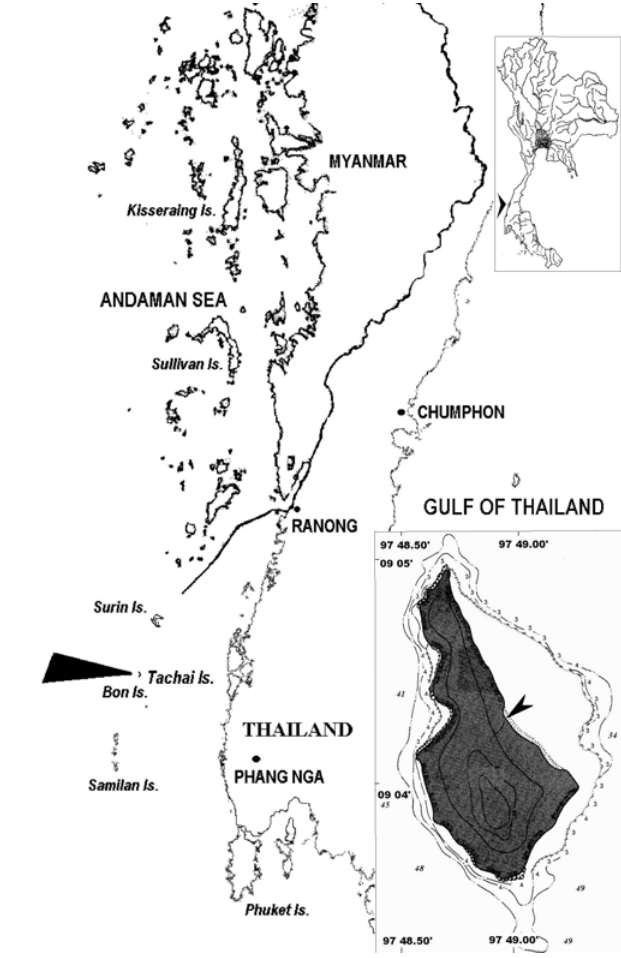
Figure 1. The part of the Mergui Archipelago adjacent to the western coast of the Thai Peninsula showing location of the type specimens, Kesseriang and Sullivan Islands; and current recorded specimens from Ko Tachai (Tachai Island), southern Thailand (indicated by black arrow). Inset: Ko Tachai (Tachai Island), with arrow indicating collecting area of Phricotelphusa callianira (De Man, 1887), in this report.